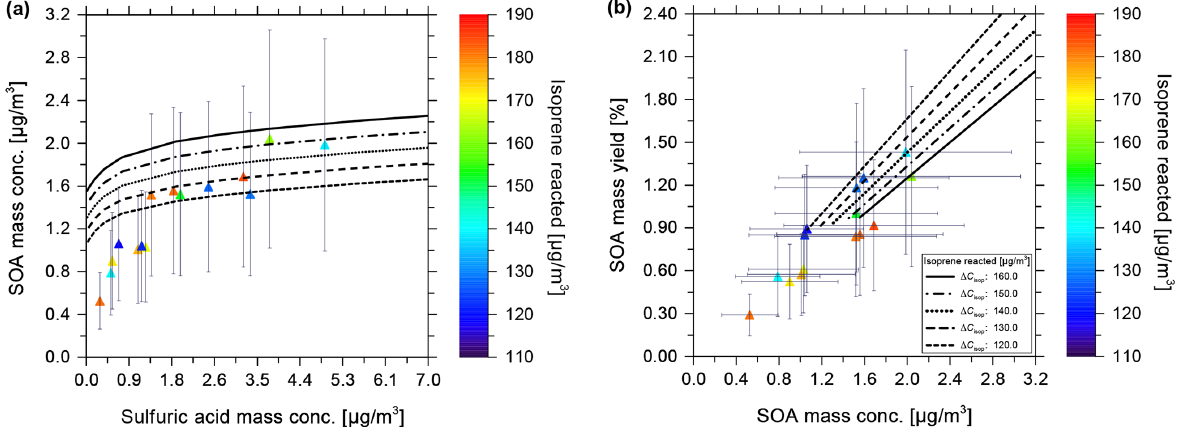
Figure 8. Comparison of chamber data and model calculations for isoprene SOA formed at different sulfuric acid seed mass concentrations. Experimental conditions are 10 ◦ C and ∼ 85% RH with sulfuric acid seed particles; model calculations were carried out for the same conditions and a range of isoprene and seed mass concentrations. (a) Measured and calculated SOA mass concentration vs. sulfuric acid mass concentration, where solid triangles show the continuous flow chamber data (partially corrected; Fuchs, 2017) at different [ISOPRCT] levels (colour scale). Black curves show the model predictions for distinct levels of [ISOPRCT] indicated in panel (b) . (b) Measured and predicted SOA mass yields vs. SOA mass